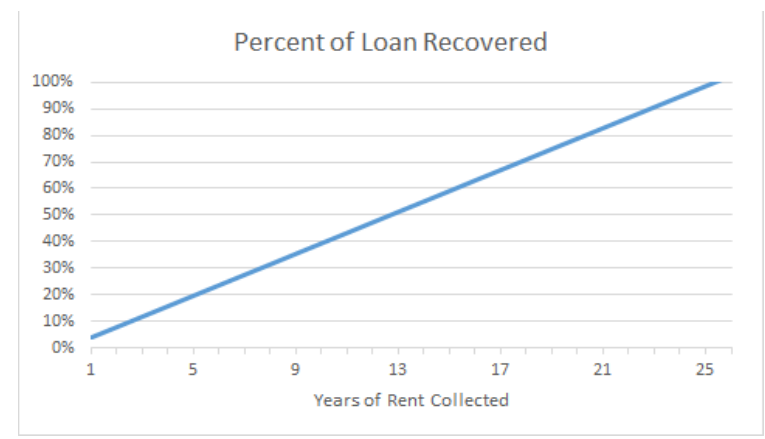
Figure 13. Length of time for rent to pay back the property value.